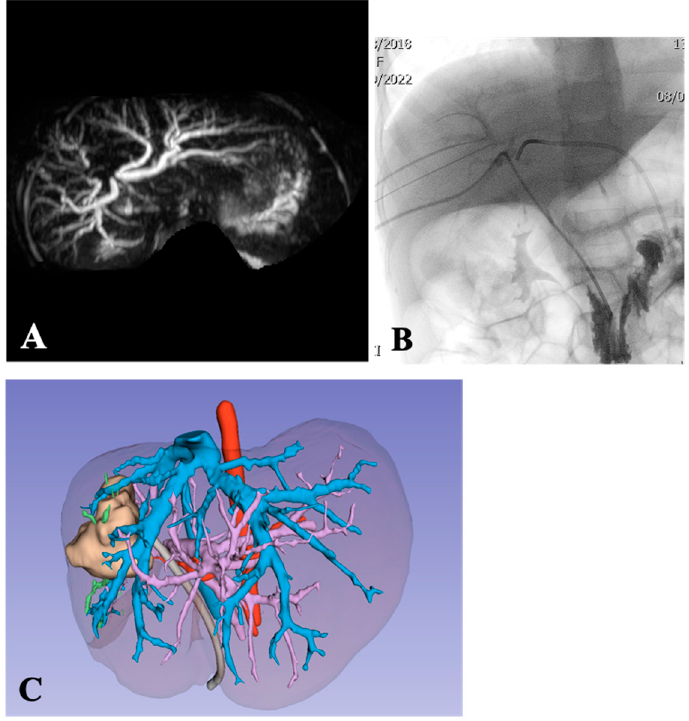
Figure 5. ( A ): Cholangio MRI of patient n. 12 showed a sizeable hepatic lesion of the right lobe extended from the subcapsular region to the hilum and determined biliary tree compression. The vascular branches form an intricate “caput medusae.” ( B ): Combined approach with percutaneous cholangiography and ERCP. The combined approach (Randez-vous) permitted to insert of a guidewire (0.035–400 mm), allowing a balloon dilatation (6 mm) and the stenting (8.5 F–12 cm). ( C ): VR reconstruction after removal of the left biliary stent. The intrahepatic right biliary tree could not be fully visualized due to complete obstruction of the anterior and posterior segments.